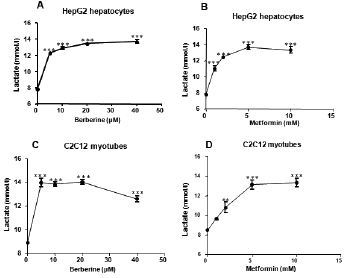
Figure 3. Berberine increased lactate release in a dose- dependent manner in cultured cells. Cells were cultured in 96- well plates. Lactate concentration was measured after treatment with increasing concentrations of berberine or metformin in serum-free medium for 24 h. A: Effect of berberine on lactate release in HepG2 cells. B: Effect of metformin on lactate release in HepG2 cells. C: Effect of berberine on lactate release in C2C12 cells. D: Effect of metformin on lactate release in C2C12 cells. Data are expressed as means 6 SEM; n= 4. ** P , 0.01 and *** P , 0.001 vs . corresponding control (0 mol/L).